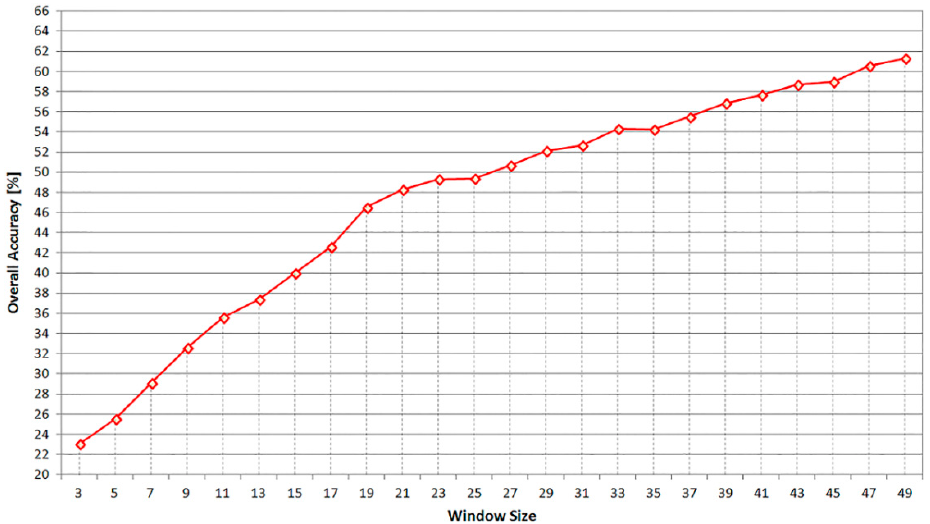
Figure 6. Overall Accuracies of the classifications of textures with different window sizes.